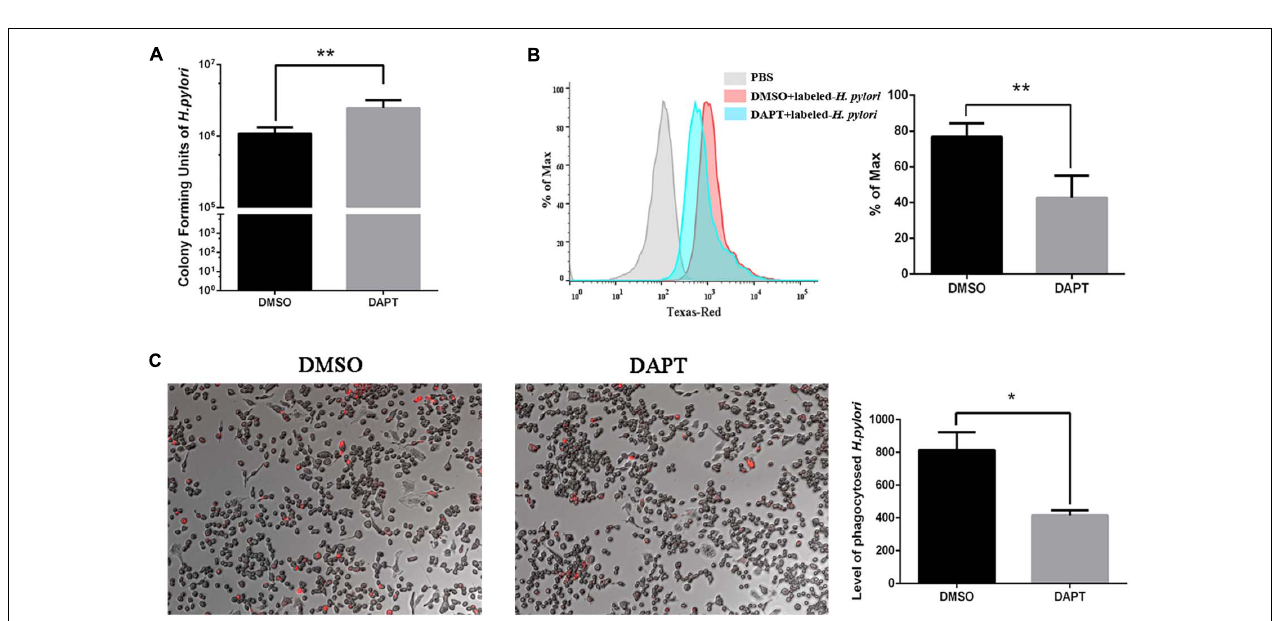
FIGURE 2 | Inhibition of Notch diminishes the bactericidal activity of macrophages to H. pylori via phagocytosis. RAW264.7 was pretreated with 40 µ M DAPT for 12 h and then were co-cultured with Texas Red-labeled H. pylori (MOI = 50) for 3 h. DMSO (0.08%) was used as control for DAPT. PBS was used as control for H. pylori infection. (A) H. pylori in the supernatant was collected and cultured on plates for 7 days to calculate colony-forming units (CFUs) of H. pylori . (B) The level of Texas Red-labeled H. pylori in RAW264.7 cells was determined by flow cytometry. The gray, red, and blue regions represent the background, DMSO-treated RAW264.7 cells, and DAPT-treated RAW264.7 cells, respectively. Representative histograms of Texas Red staining within RAW264.7 cells were assessed by FlowJo_V10 software. PBS group was to distinguish the fluorescence background. (C) The Texas Red-labeled H. pylori in RAW264.7 cells were observed under a fluorescence microscope. Images were captured using a fluorescence microscope (200 × ). The red dots represented the Texas Red-labeled H. pylori . The total fluorescence intensity of Texas-Red was analyzed by ImageJ (Version 5.12a) software. The histogram reflected the mean fluorescence intensity (MFI). MFI = (the total fluorescence intensity of Texas Red)/(the number of cells). Data are presented as the mean ± SD of three independent experiments. * p < 0.05, ** p < 0.01.